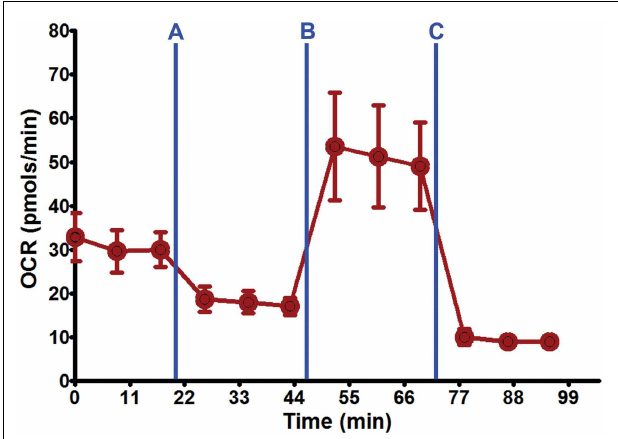
FIGURE 3 | Seahorse XF24 mitochondrial stress analysis. Using the optimal seeding density (50,000 cells/well) and coating substrate combination (poly-lysine + 10% collagen) on 24-well Seahorse XF24 polystyrene microplate, well-adhered, and dispersed DRG neuronal cultures were maintained throughout the culture process and Seahorse XF24 analysis (7 DIC). Each data point is presented as mean ± SEM. Injection series: (A) Oligomycin (1.5 µ M); (B) FCCP (0.75 µ M); (C) rotenone (1.0 µ M) and antimycin A (1.0 µ